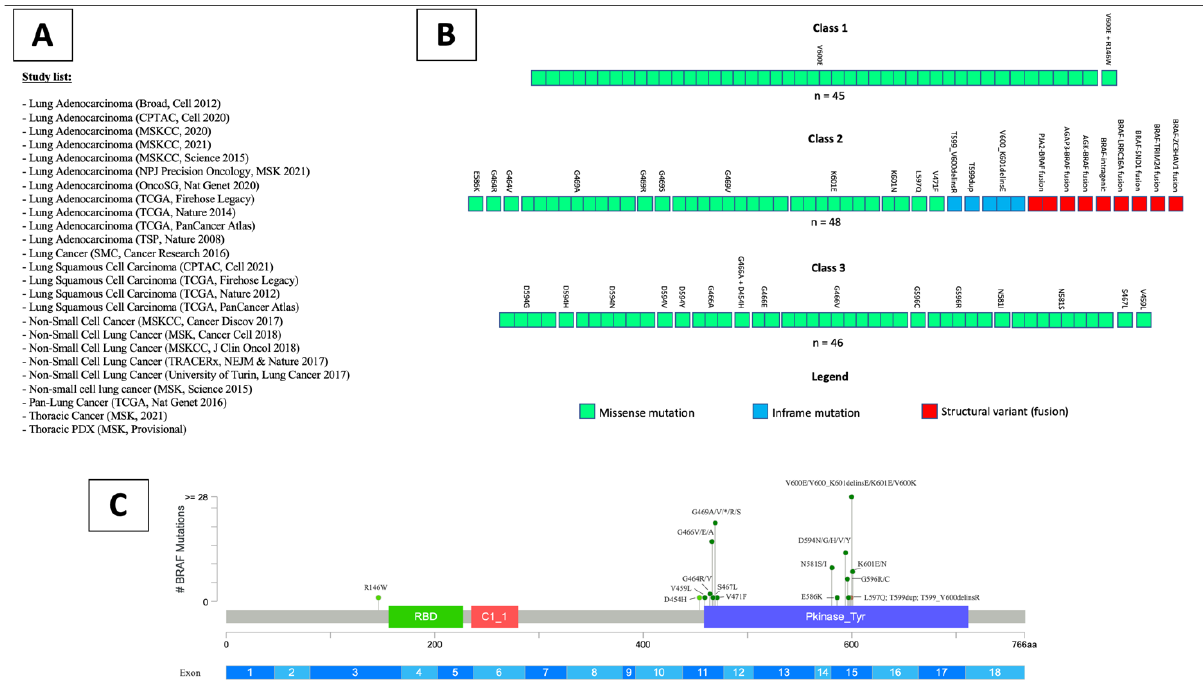
Figure 1. List of studies analyzed through the cBioPortal online platform containing available clinical and genomic data ( A ). Representation of patients (squares) analyzed for each class of BRAF alterations, and corresponding BRAF alteration detected ( B ). Lollipop plot showing the position of detected BRAF class 1, 2 and 3 mutations in the BRAF gene sequence ( C ).